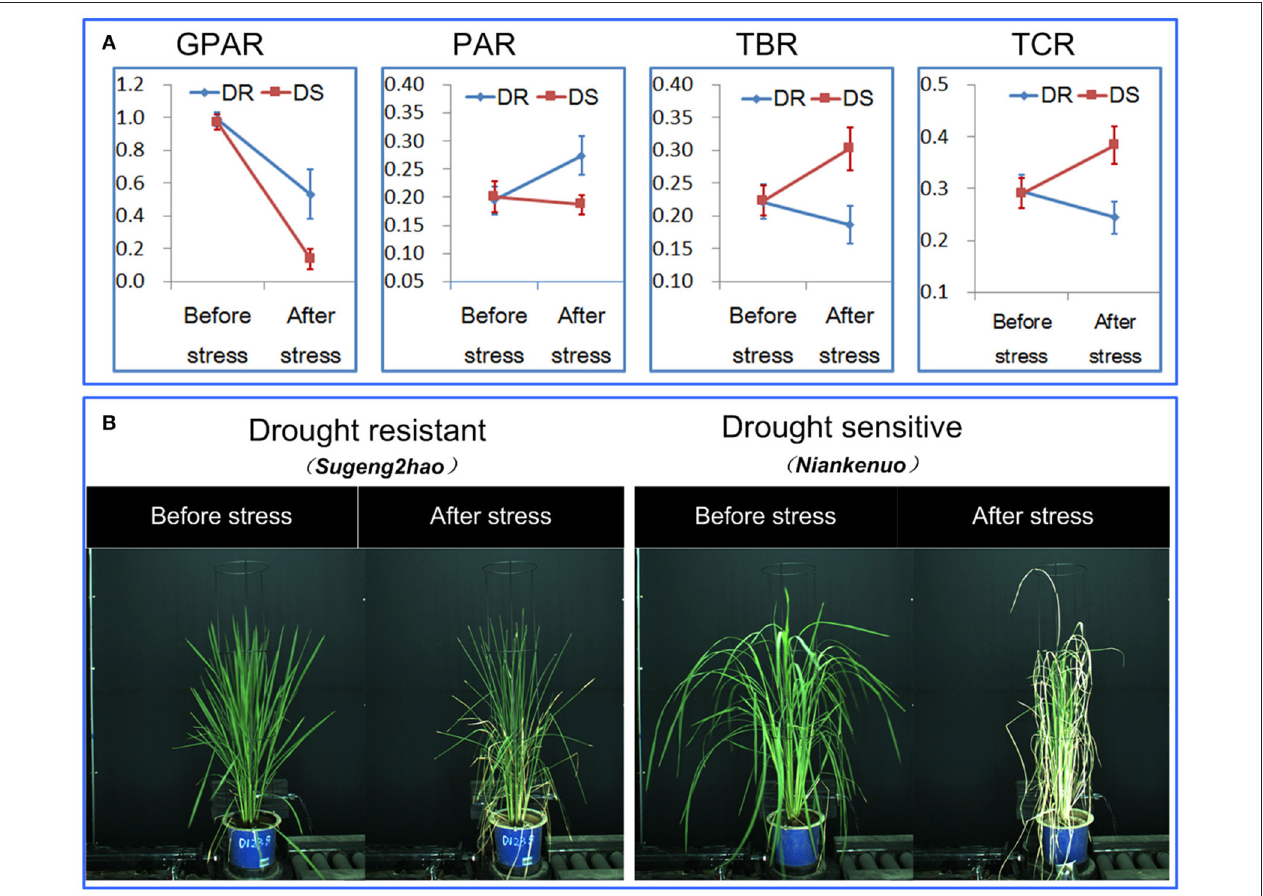
FIGURE 3 | Discrimination between rice drought resistant and drought sensitive accessions. (A) General dynamics of 4 drought-related features before/after stress between drought resistant and drought sensitive accessions. The markers and the bars in each line represent the mean value and standard deviation across the accessions, respectively. (B) A drought resistant and a drought sensitive accession before and after